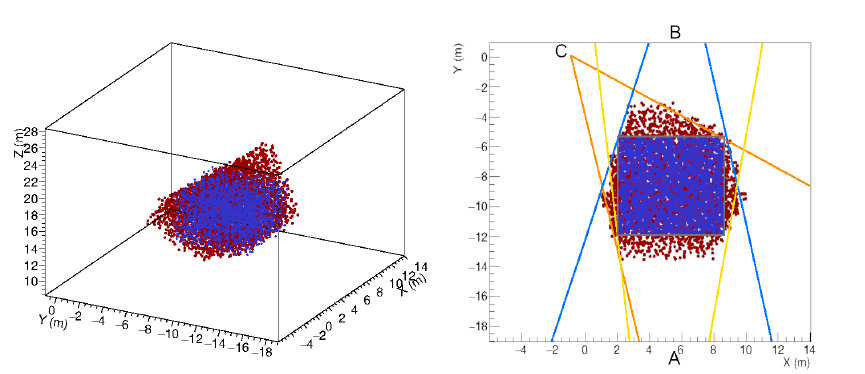
Figure 7. Denoising process of the 3D reconstructed object. The XY-view on the right shows the predicted object (blue), the 3D reconstructed object (red) and the reference object (gray) in the space constrained by the viewing angle of the detectors placed in positions A, B and